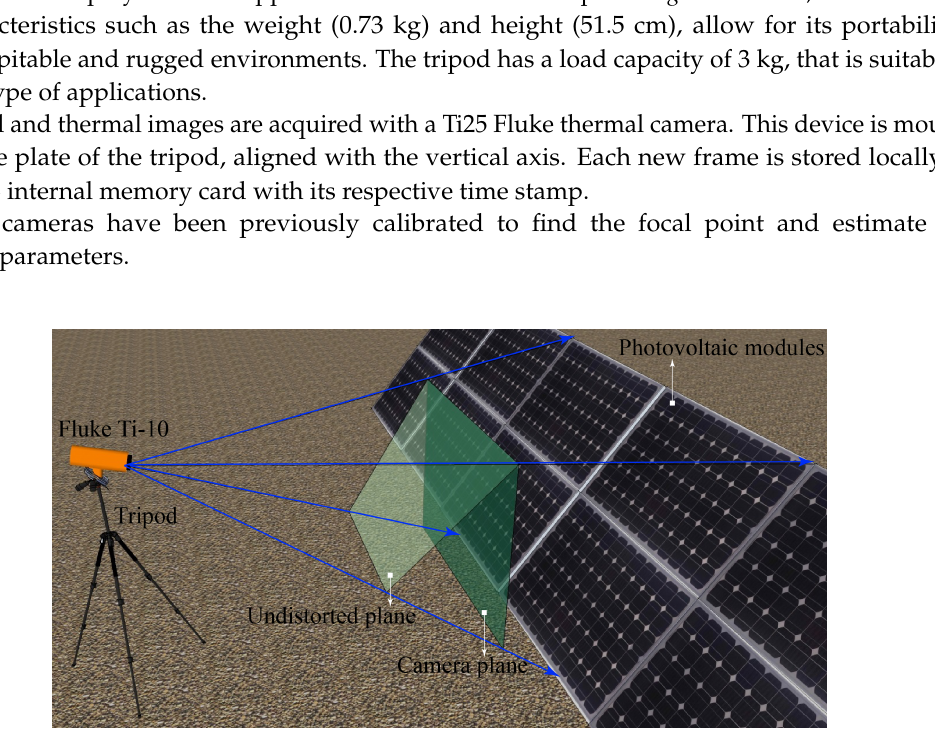
Figure 2. Proposed measurement system. The system is composed of an thermal camera Fluke Ti25, which is provided with a monocular RGB and infra-red camera. The device was mounted on a commercial tripod.